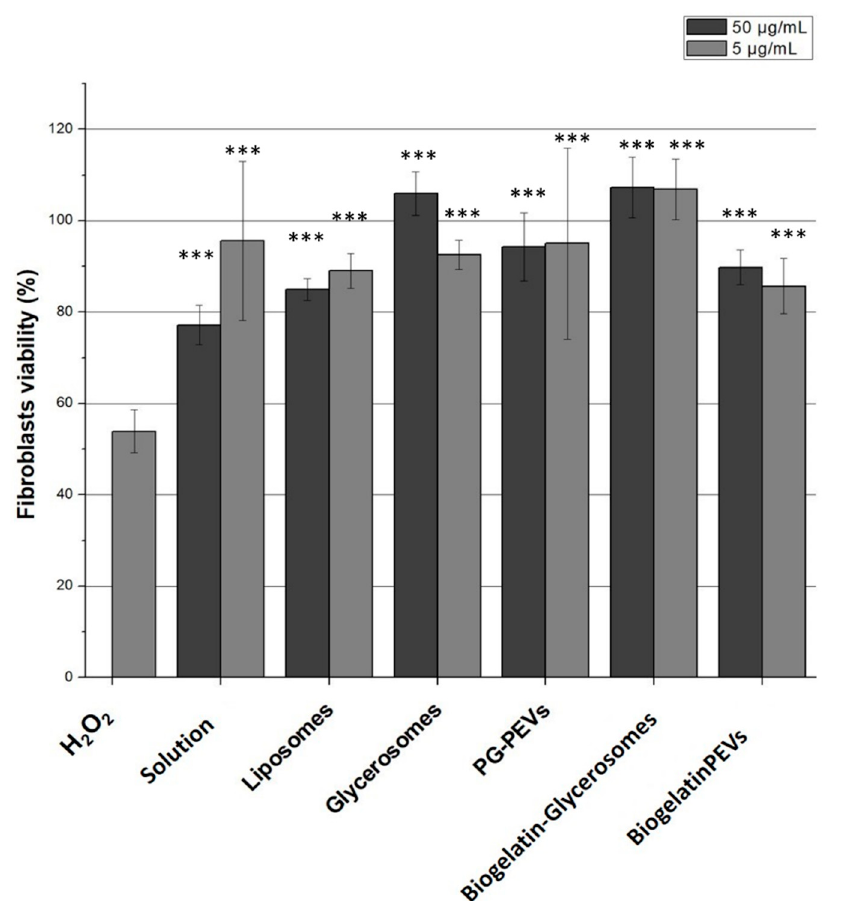
Figure 4. Antioxidant assay of L. citriodora loaded vesicles performed on fibroblasts (*** = p value < 0.001).